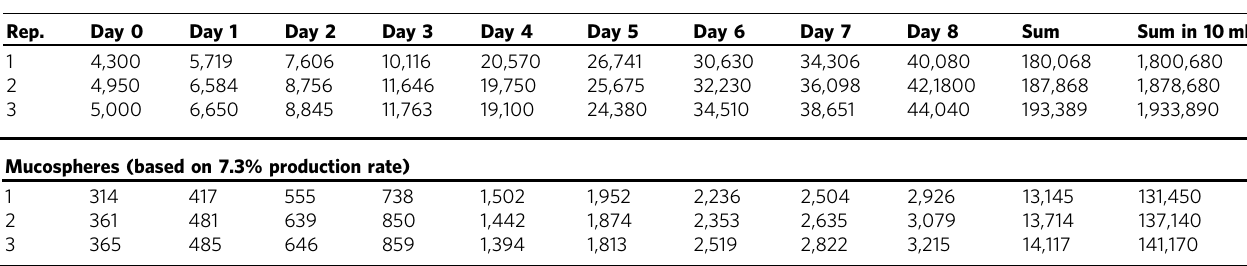
Table 3 Prorocentrum cf. balticum cell abundance from measured and calculated growth rate values over the growth period and the number of mucospheres estimated to have been in each mucus fraction for which carbon was quanti fi